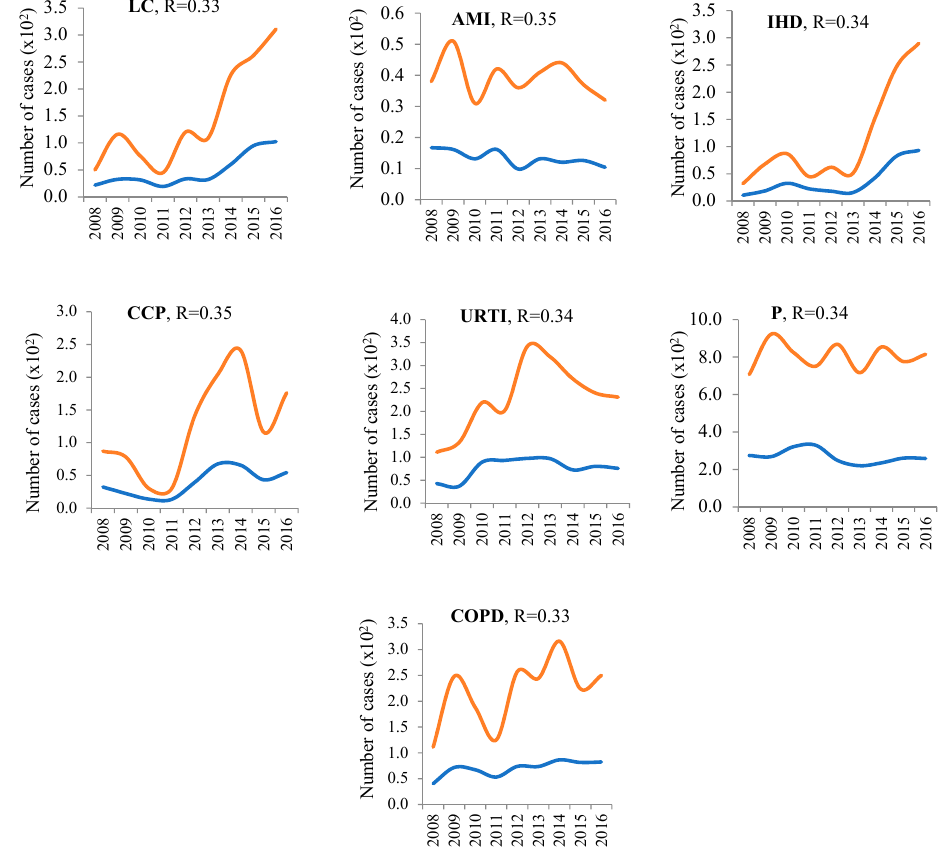
Figure 13. Health endpoint attributable to short- and long-term exposure to PM 10.